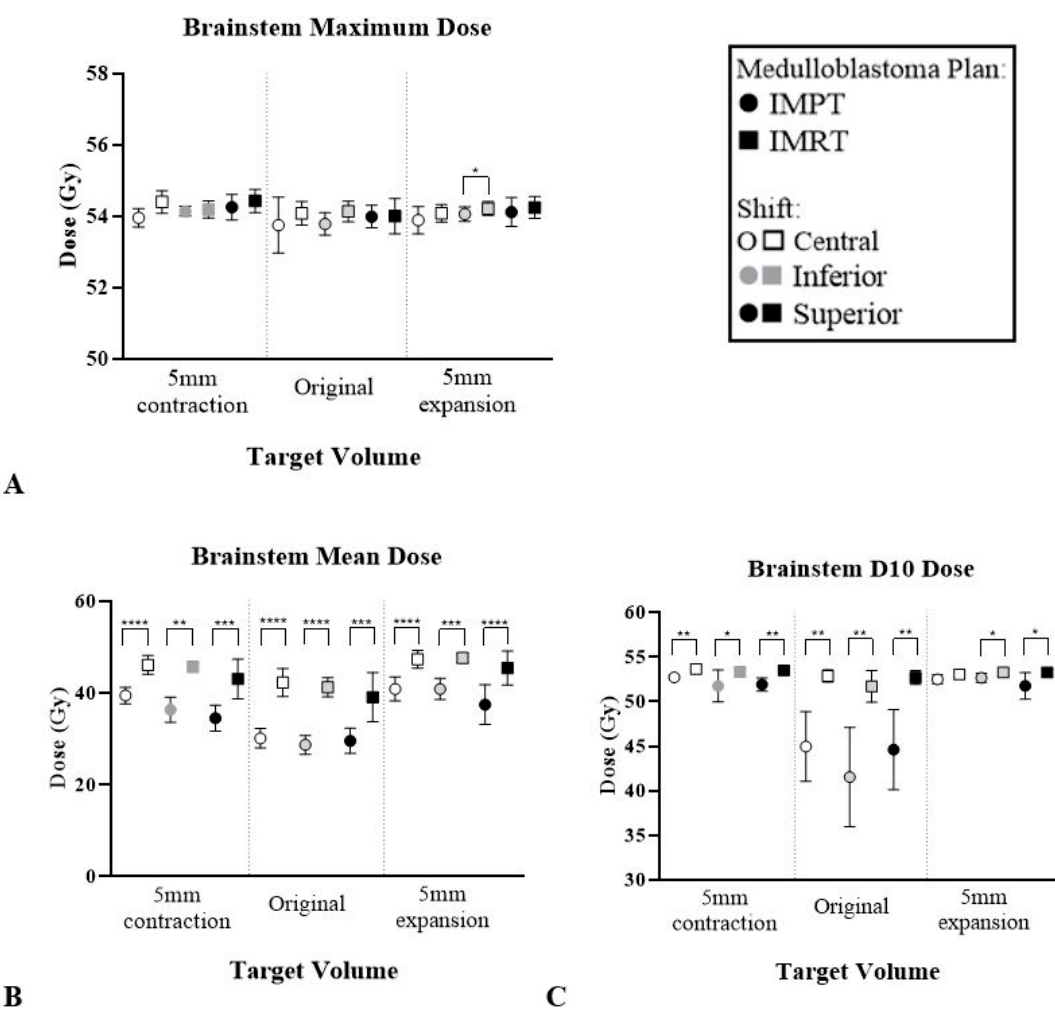
Figure 5. Average dose to brainstem across six patients across IMPT and IMRT plans for three MB volumes and locations. ( A ) Maximum dose. ( B ) Mean dose. ( C ) Dose to 10% of the structure. Paired t -test error bars represent the 95% confidence interval of the mean. * p < 0.05, ** p < 0.01, *** p < 0.001, **** p < 0.0001.